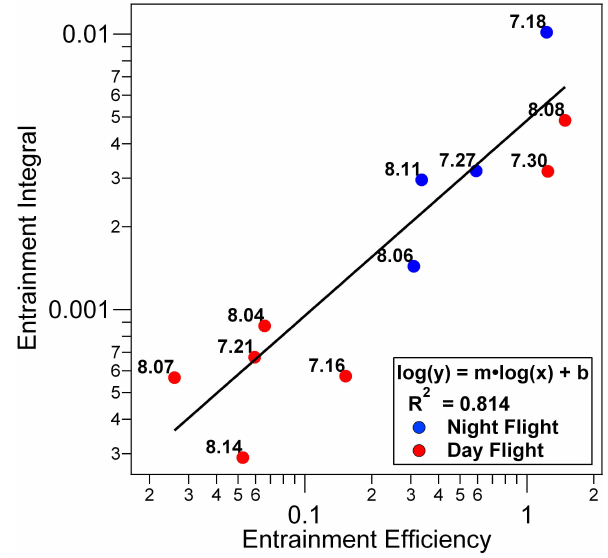
Fig. 7. Scatter plot of the boundary layer integral, R + F b , versus mean cloud top height. Each point is the average value for the flight, with the corresponding date beside each point, and color denoting day and night flights. mm